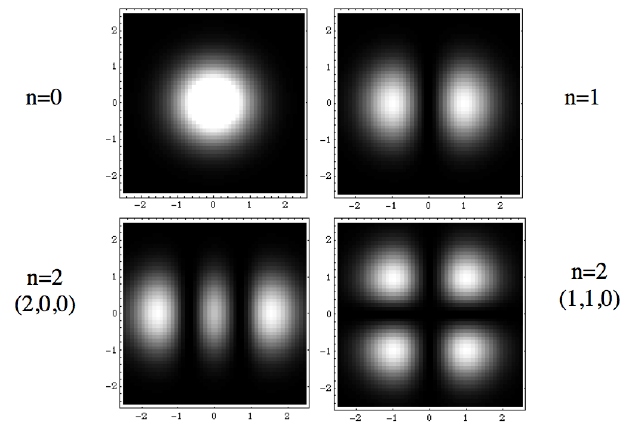
Figure 1. Example of quantized structures: solutions of a Schr ¨ odinger equation for an harmonic oscillator